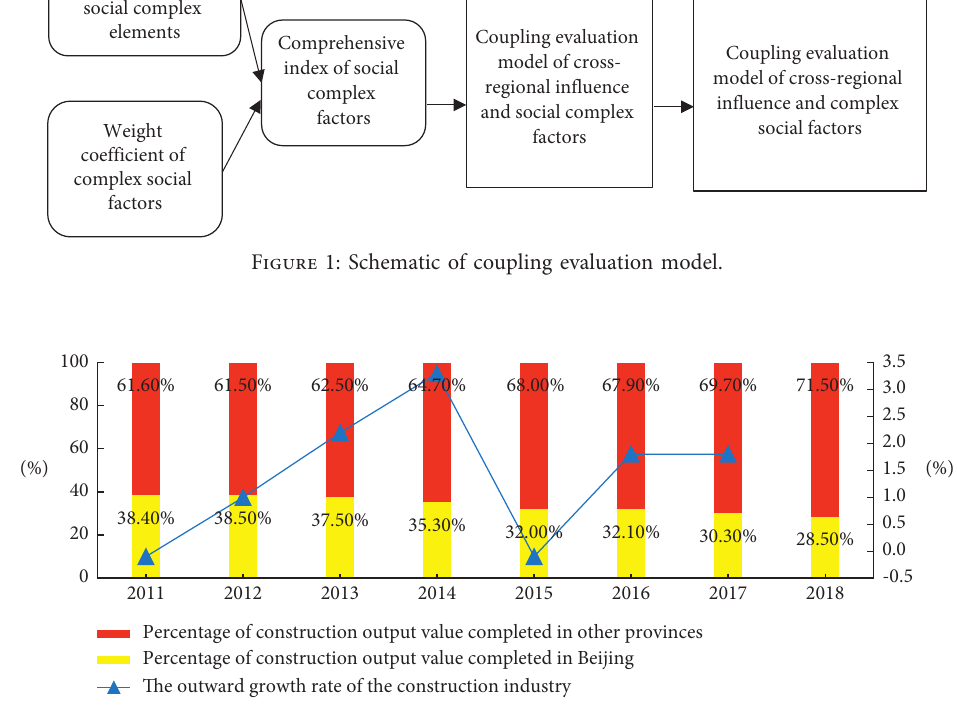
Figure 2: Proportion of the regional completion value in Beijing’s construction industry from 2011 to 2018.